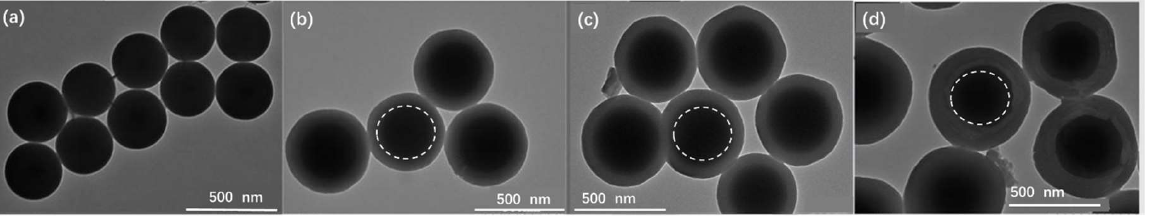
Figure 1. TEM images of SiO 2 and coated core–shell nanoparticles: ( a ) SiO 2 , ( b ) SiO 2 @PZS−1, ( c ) SiO 2 @PZS−2, ( d ) SiO 2 @PZS−3.